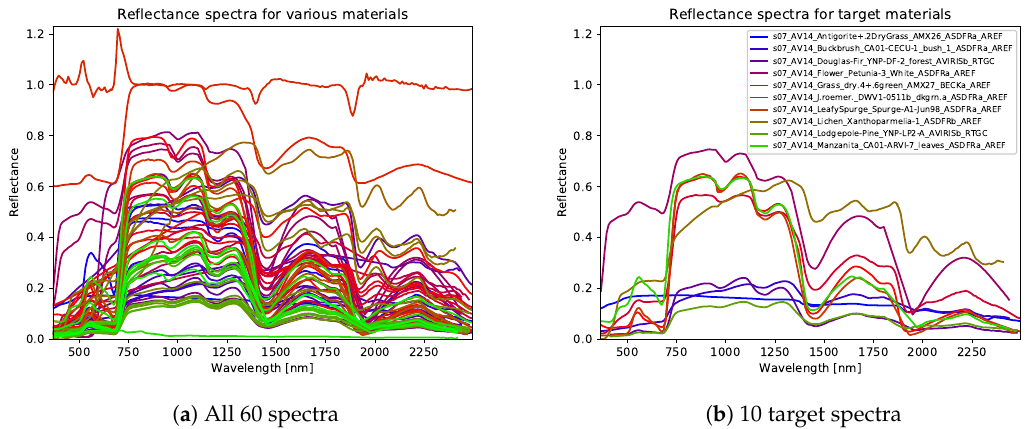
Figure 10. Reflectance spectra used for this dataset ( a ). The 10 target spectra on the right ( b ) are a subset of the 60 spectra. The filenames of these target spectra in the USGS Library are